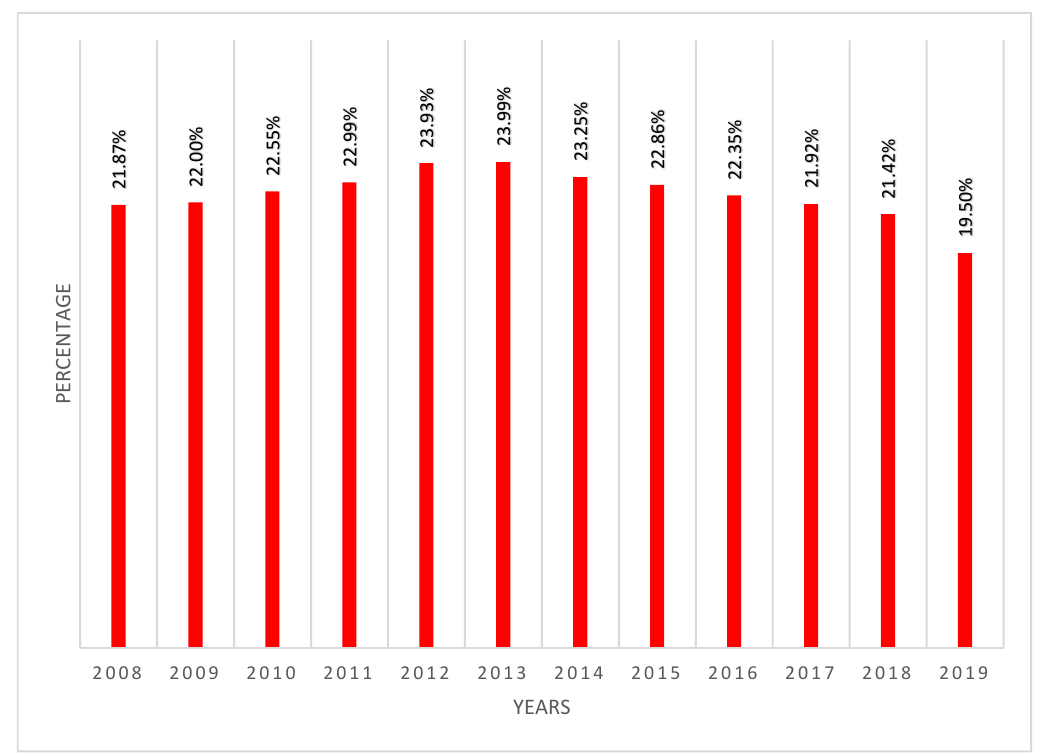
Figure 10. Women’s pay gap compared to men (period 2008–2019). Source: Authors with data from the Annual Salary Structure Survey provided by the Statistics National Institute ( Instituto Nacional de Estadística ). Table 9. Average yearly wage by sex (in